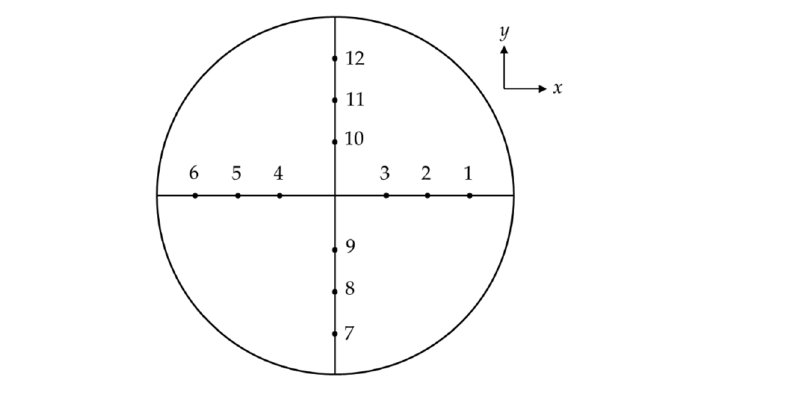
Figure 10. Distribution of wind speed measurement points inside the large-aperture channel. Table 1. Experimental and simulation data of wind speed at the measurement point.